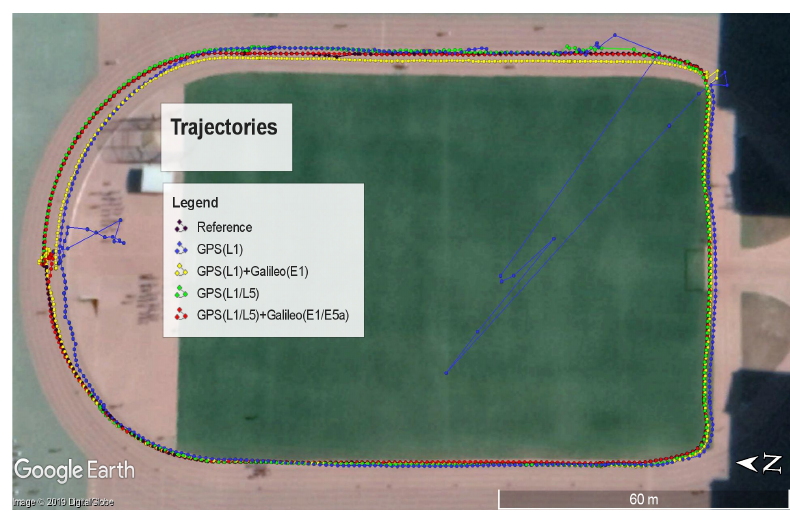
Figure 9. RTK performances shown in Google Earth. Table 1. Statistics of positioning errors in the ECEFcoordinate (sports ground).